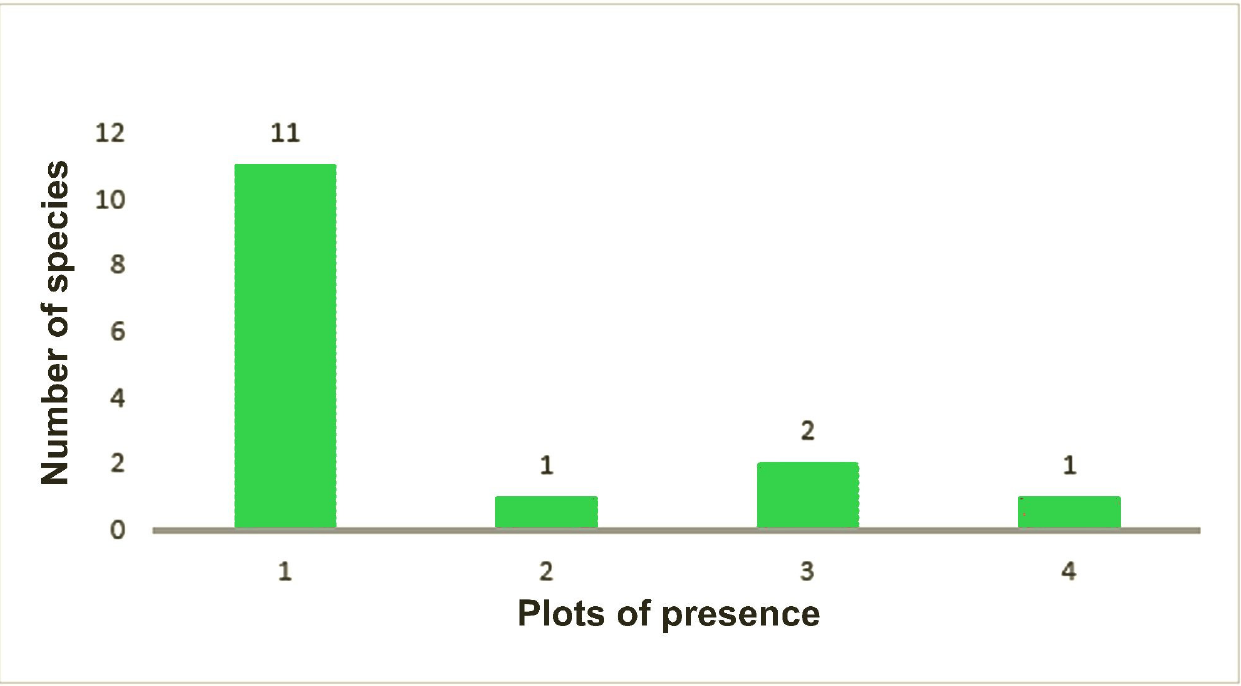
Figure 9. Abundance of singleton + doubleton species in Otonga primary and secondary forest.